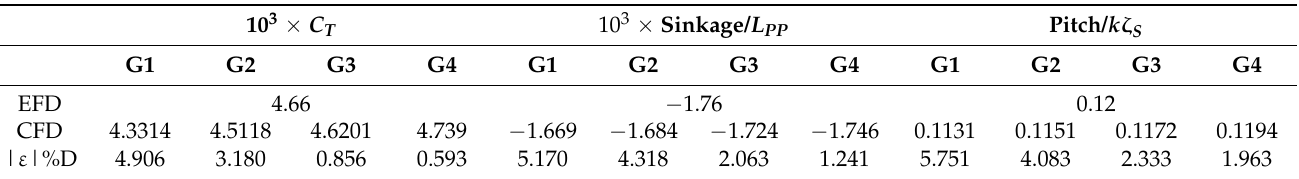
Table 2. Grid sensitivity study for the mean values of the total resistance coefficient, sinkage, and trim computed in calm